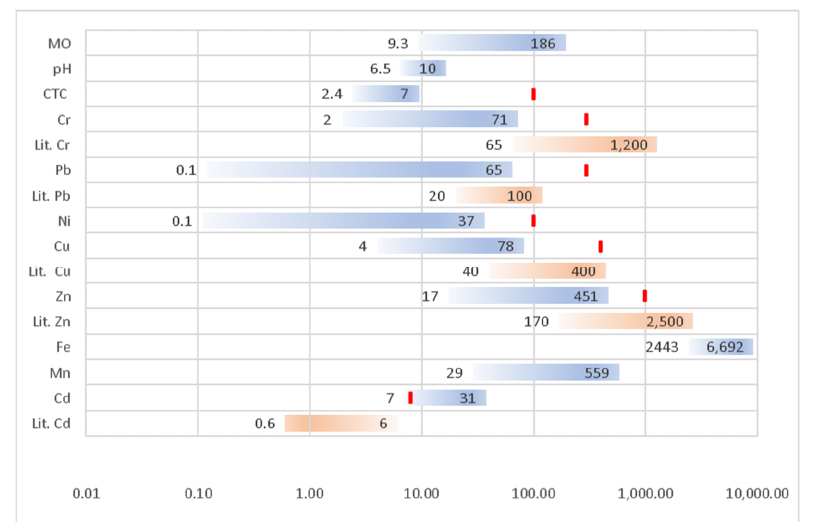
Figure 4. Range of soil concentrations sampled in the infiltration swale soil in 2014–2017. Concentrations are in mg/kg. Orange boxes with acronym Lit. preceding the pollutant name indicate literature concentration ranges [3]. The red line indicates the chemical concentration for the Brazilian Regulatory Limit for residential use soils [49]. MO: organic matter; CEC: cation exchange capacity. All metal ions present in the runoff were found in the soil samples. Only Cd was out of compliance with the values presented in BRL. Cadmium concentrations were investi- gated in 2014 and 2015; however, in 2016 and 2017, due to analytical problems Fe was analysed instead of Cd. This substitution occurred due to problems with the metal reading equipment. This metal (Fe) showed the highest concentrations during monitoring. The measured pH was considered neutral, with the exceptions of the sampling that occurred in 2015 (8.69 to 10.14). Soil pH is an important property in controlling chemical reactions. Generally, the mobility of metal cations increases as the acidity of the medium increases. However, this relationship is more variable for oxyanions. The soil results indicate that the cation exchange capacity (CEC) and the amount of organic matter remained low. The CEC ranged from 2.40 to 7.12 cmolc/dm 3 and the or- ganic matter from 9.34 to 185.81 g/kg. Organic matter was present in all samples, with higher rates in the superficial samples (P1). The greatest variation in organic matter con- centrations were found in 2016, but it does not reflect in the increase in CEC. The CEC retained similar values during all investigated years. Indeed, organic matter has a binding affinity for some metals, including Cu, Ni, Pb, Co, Ca, Zn, Mn and Mg [50]. The metals Zn, Fe and Mn presented higher concentrations than the other elements investigated. Fe and Mn are the heavy metals that usually appear in larger quantities in Brazilian soils [51]. The natural occurrence of heavy metals in soil depends on the rock matrix from which the soil was formed, the formation processes, composition, and pro- portion of its solid phase. The range of concentrations of the metals sampled at the bottom of the swale is pre- sented in Figure 4. All the pollutant concentrations in soil were well below the BRL for residential soils [49] and literature values. The exception is Cd, which showed four times